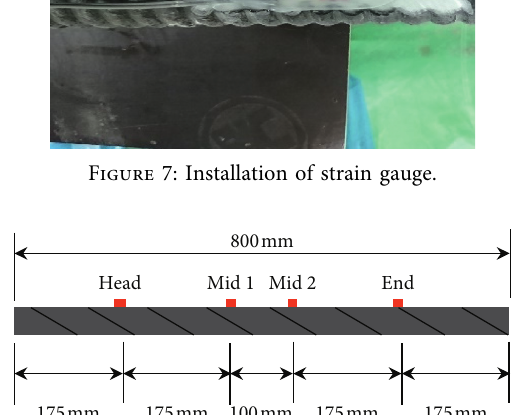
Figure 8: Installation position of the strain